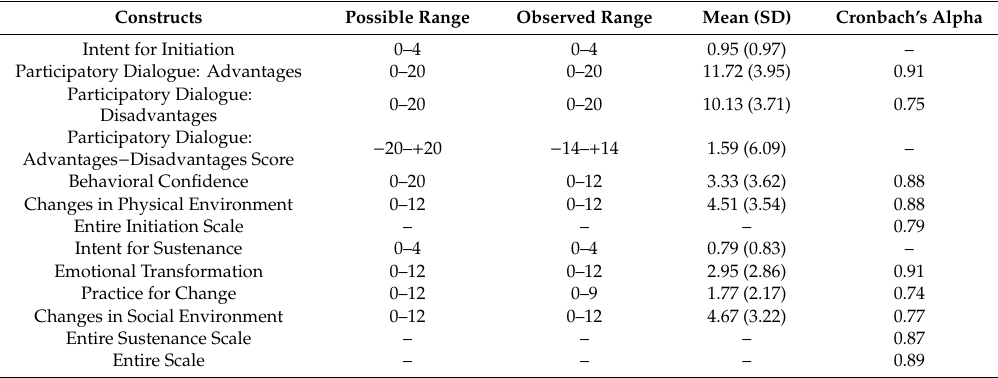
Table 2. Descriptive Statistics of Constructs of Multi-Theory Model (MTM) ( N = 140).